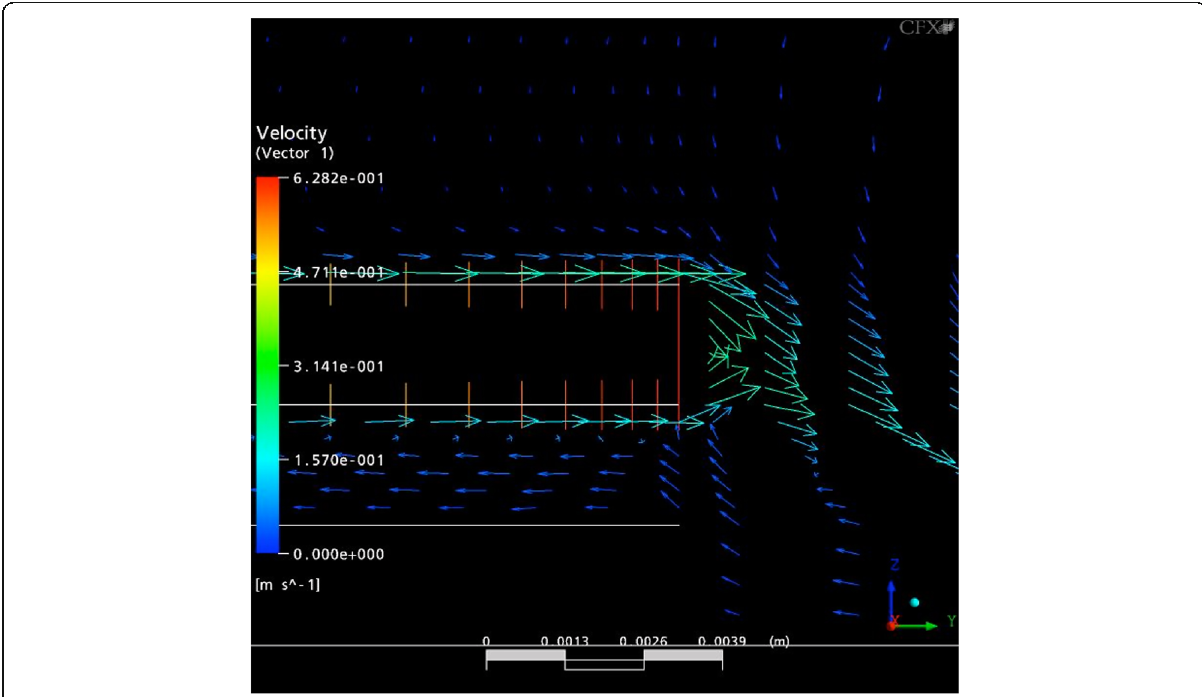
Fig. 2 Side view of a computerized simulation, showing the flow chambers ’ lower compartment and the flow profile in between the two plates; shearing gap and bottom plate are shown on the left side; rotation speed = 200 rpm; colour code bar ( left edge ) showing shear force values [Pa] [1 Pa = 10 dyn/cm 2 ]; flow direction presented by